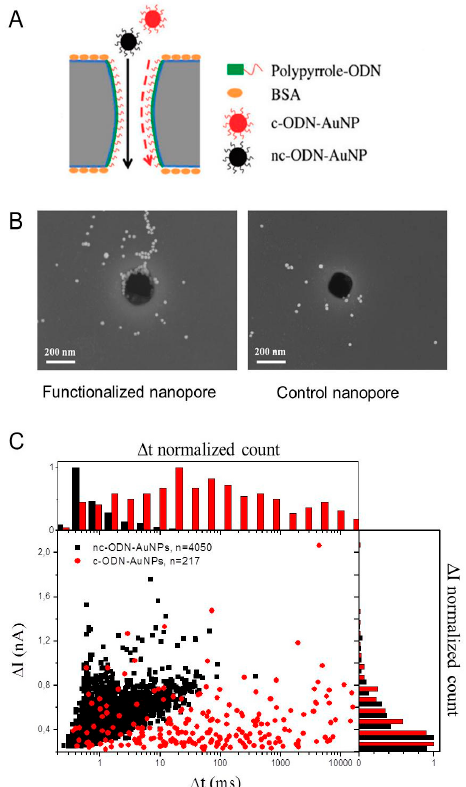
Figure 7. Functionalized nanopore sensing of oligodesoxyribonucleotide (ODN)-coated nanoparticles. ( A ) A nanopore electro-functionalized with oligonucleotides via CLEF was employed for the detection of gold nanoparticles carrying complementary (red) or non-complementary (black) ODNs. ( B ) SEM characterization of (a) functionalized or (b) non-functionalized nanopores. ( C ) Electrosensing. The current, measured via platinum electrodes, distinguishes the passage of complementary and non-complementary targets in the ODN-electro-functionalized nanopore.